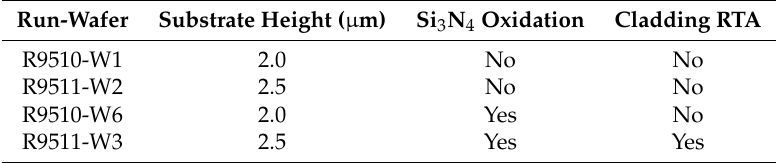
Table 3. Runs and wafers with different processing steps: substrate height, waveguide oxidation and cladding rapid thermal annealing